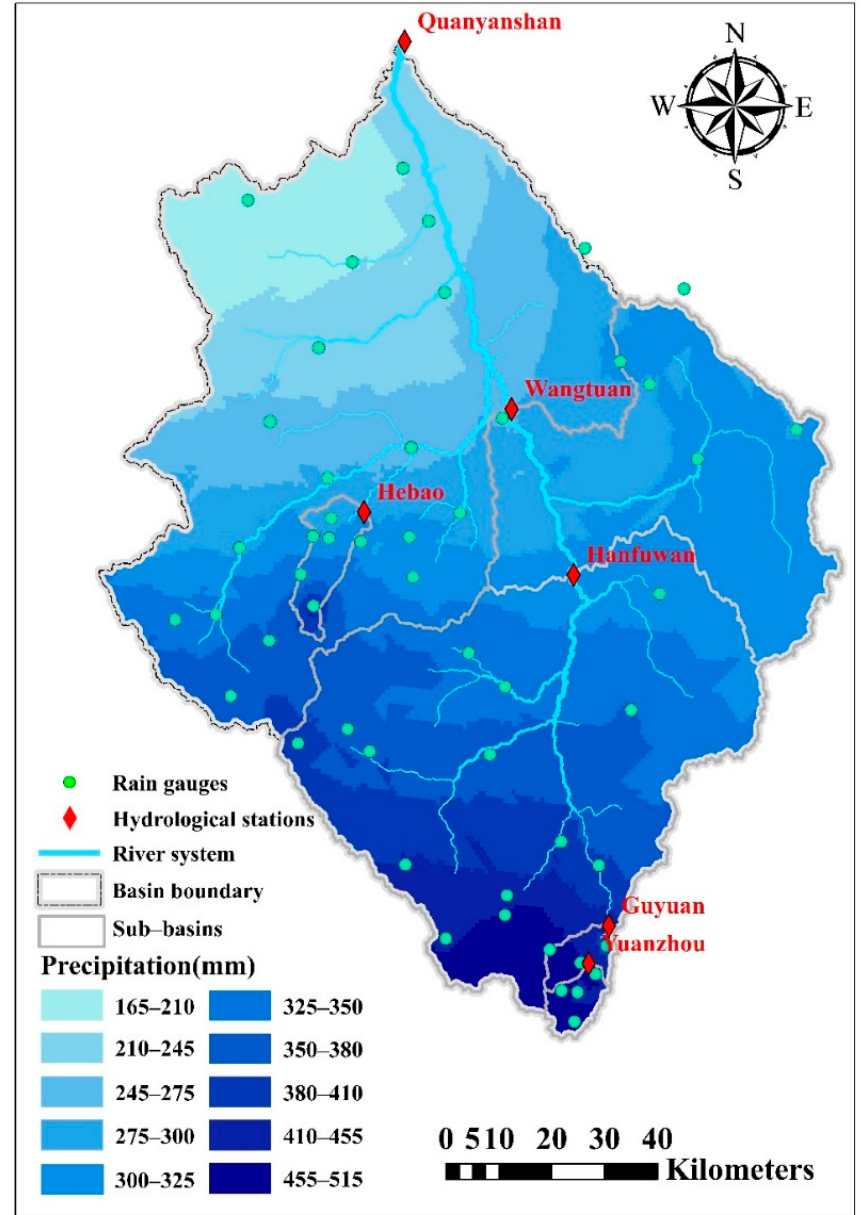
Figure 2. Spatial distribution of the average annual precipitation in the QRB from 2006 to 2016.